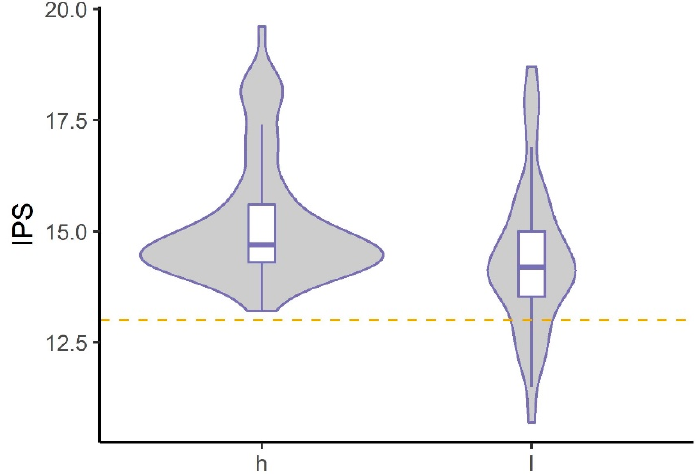
Figure 13. Violin plot of IPS index values based on the composition of deployed and natural reeds’ epiphytic diatoms at c5 and c6 sampling points of the Cikola tributary system during periods of low water discharge (l) and water discharge above 70 m 3 s − 1 (h). Orange dashed line indicates good/moderate boundary of the index.